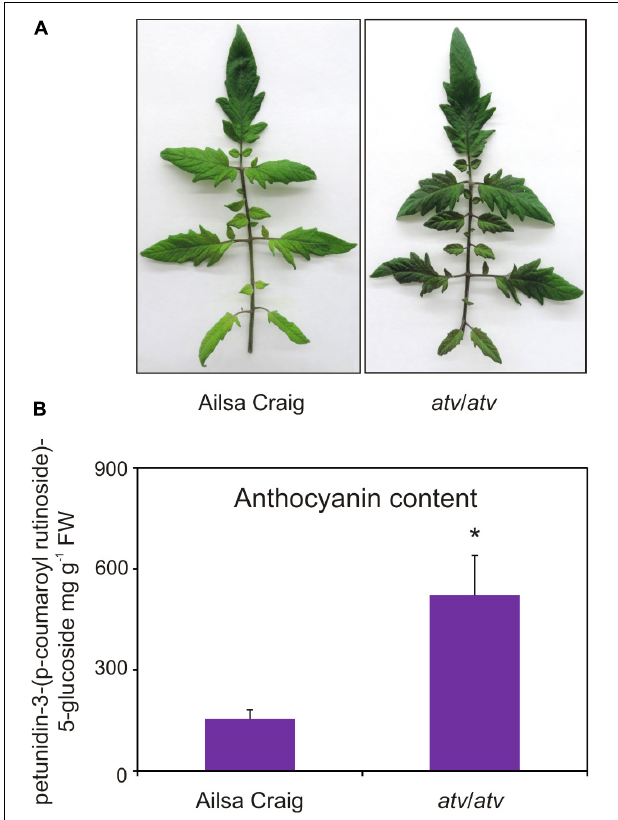
FIGURE 4 | atv mutant plants grown under non-stressing conditions contain high basal levels of anthocyanins. (A) Phenotype and (B) anthocyanin content of leaves collected from Ailsa Craig (AC) and atv / atv mutant plants in AC background grown for two months under 12h light photoperiod with a light intensity of approx. 300 µ mol photons m 2 s − 1 , and 24 ◦ C/21 ◦ C day/night temperature. Anthocyanins are expressed in mg petunidin-3-(p-coumaroyl- rutinoside)-5-glucoside g − 1 FW. Data are means of three biological replicates (single mature leaves from different plants) ± SE. Unpaired t -test ( P < 0.05) was carried out and asterisks indicate significant